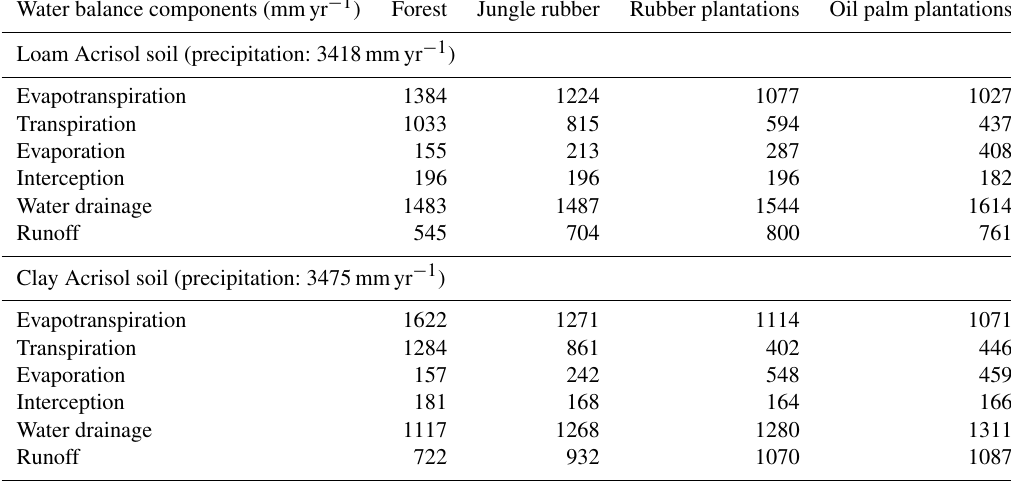
Table 1. Simulated water balance during 2013 in different land uses within the loam and clay Acrisol soils in Jambi, Sumatra, Indonesia. Water balance components (mmyr − 1 ) Forest Jungle rubber Rubber